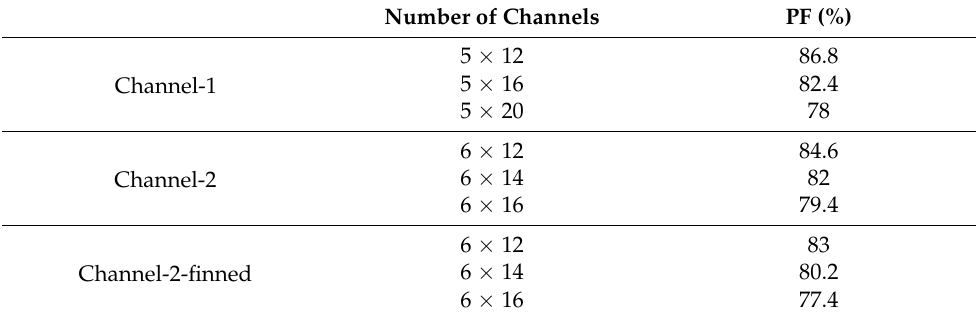
Table 2. Investigated